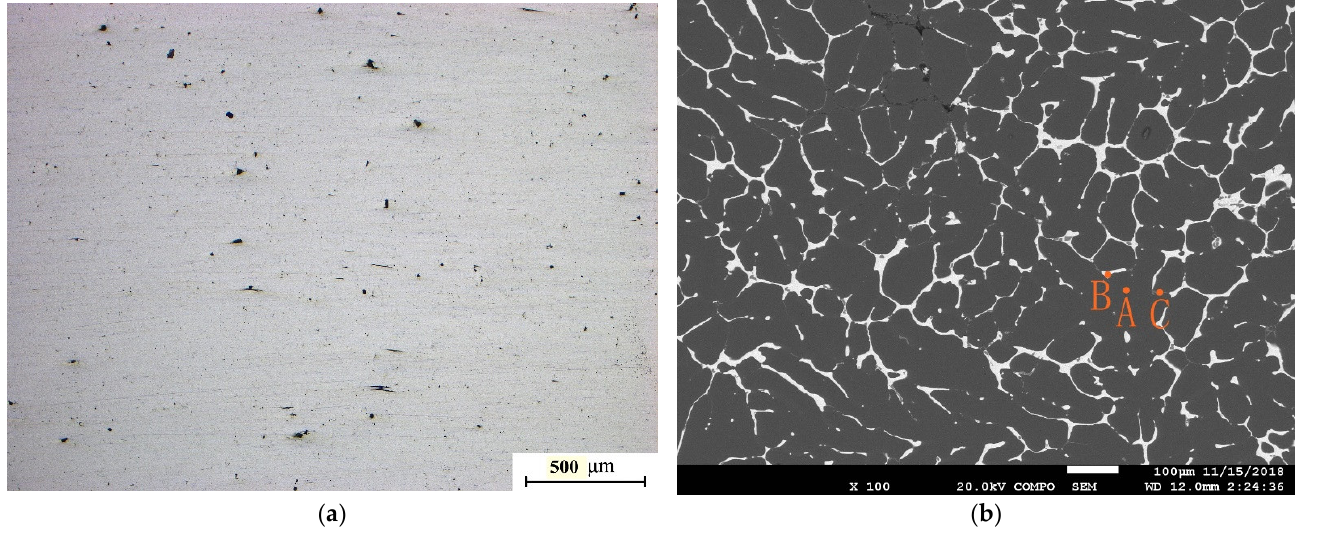
Figure 4. ( a ) Metallographic and ( b ) SEM images of the AlSn20Cu alloy fabricated using semi-con- tinuous-casting.